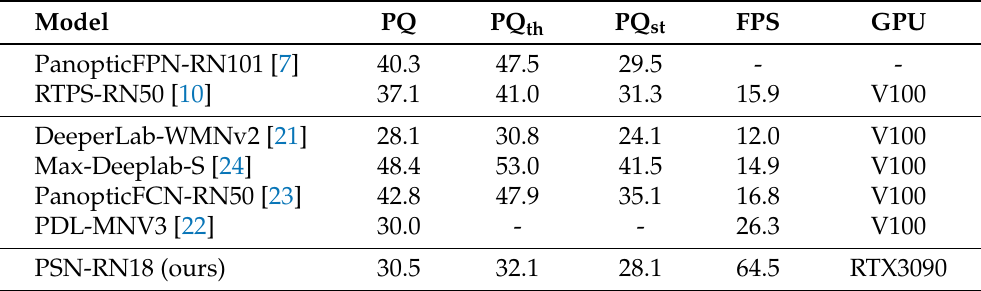
Table 4. Panoptic segmentation performance of pyramidal fusion models on COCO val. We do not optimize our models with TensorRT in order to ensure a fair comparison with the previous work. Sections correspond to top-down methods based on Mask R-CNN (top), bottom-up methods (middle), and our method based on pyramidal fusion (bottom).